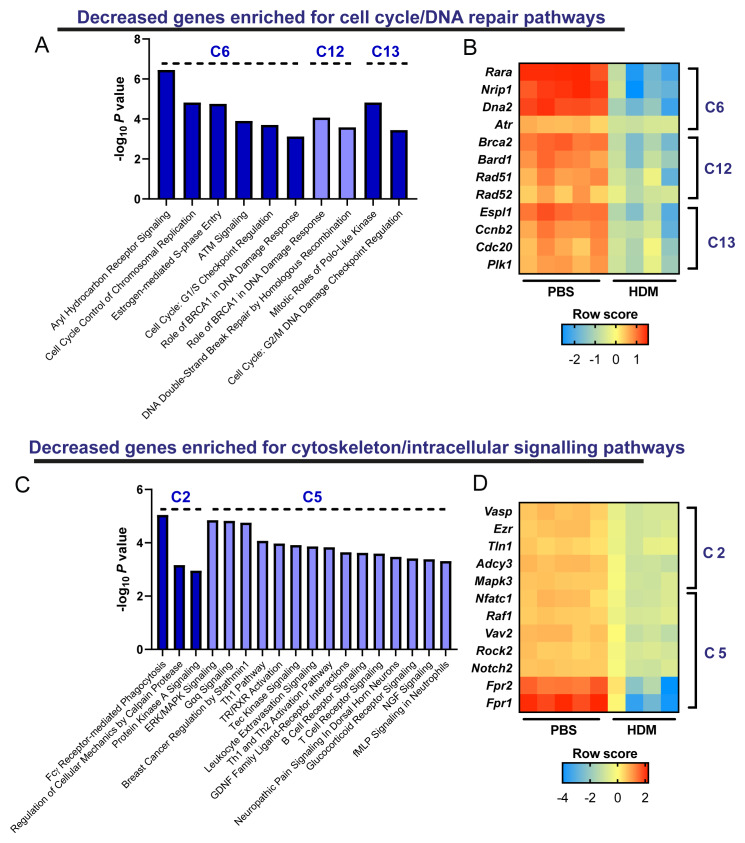
Decreased expression AM
HDM gene clusters enriched for cell cycle, cytoskeletal and intracellular signalling pathways.(
A) Highly enriched pathways for clusters of decreased genes in AMs
HDM with pathway annotations related to cell cycle and DNA replication and repair. (
B) Expression of representative genes for clusters and pathway annotations shown in (
A). (
C) Highly enriched pathways for clusters of decreased genes in AMs
HDM with pathway annotations related to cytoskeletal functions and intracellular signalling cascades. (
D) Expression of representative genes for clusters and pathway annotations shown in (
C). Bar plots show canonical pathway names and inverse enrichment Fisher’s exact
P values. Heatmaps show row-centred gene expression values (N=5 mice, PBS; N=4 mice, HDM).